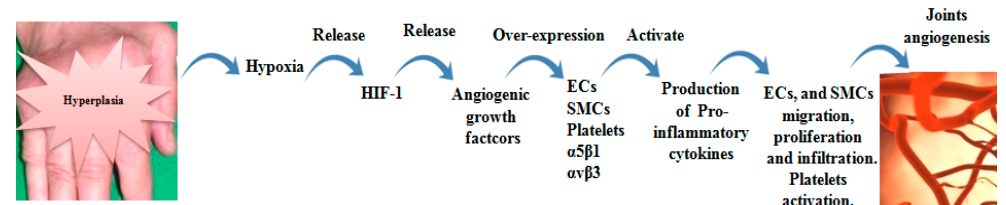
Figure 3. Role of α v β 3 and α 5 β 1 in RA joint angiogenesis. Joint hyperplasia resulted from accumulated of synovial cells and their secretions, leading to extensive hypoxia. Hypoxia conditions lead to HIF-1 release, which is recognized as a stimulator of angiogenic growth factors (VEGF, FGF-2 and PDGF). The growth factors induce α v β 3 and α 5 β 1 over-expression on endothelial cells (ECs), smooth muscle cells (SMCs) and platelets. Up-regulated α v β 3 and α 5 β 1 activate production of pro-inflammatory cytokines that mediate ECs and SMCs migration and proliferation and platelets activation. These events entrain new vascularization.